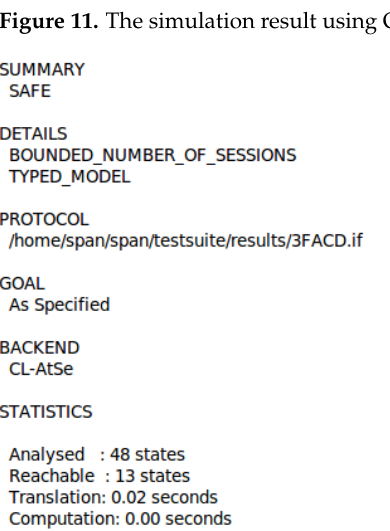
Figure 12. The simulation result using CL-AtSe back-end.